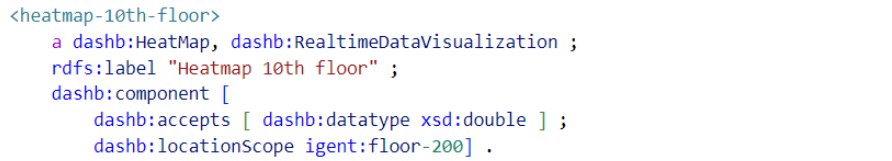
Figure 6. Semantic description in Turtle format of the real-time heatmap visualization for the 10th floor of our office